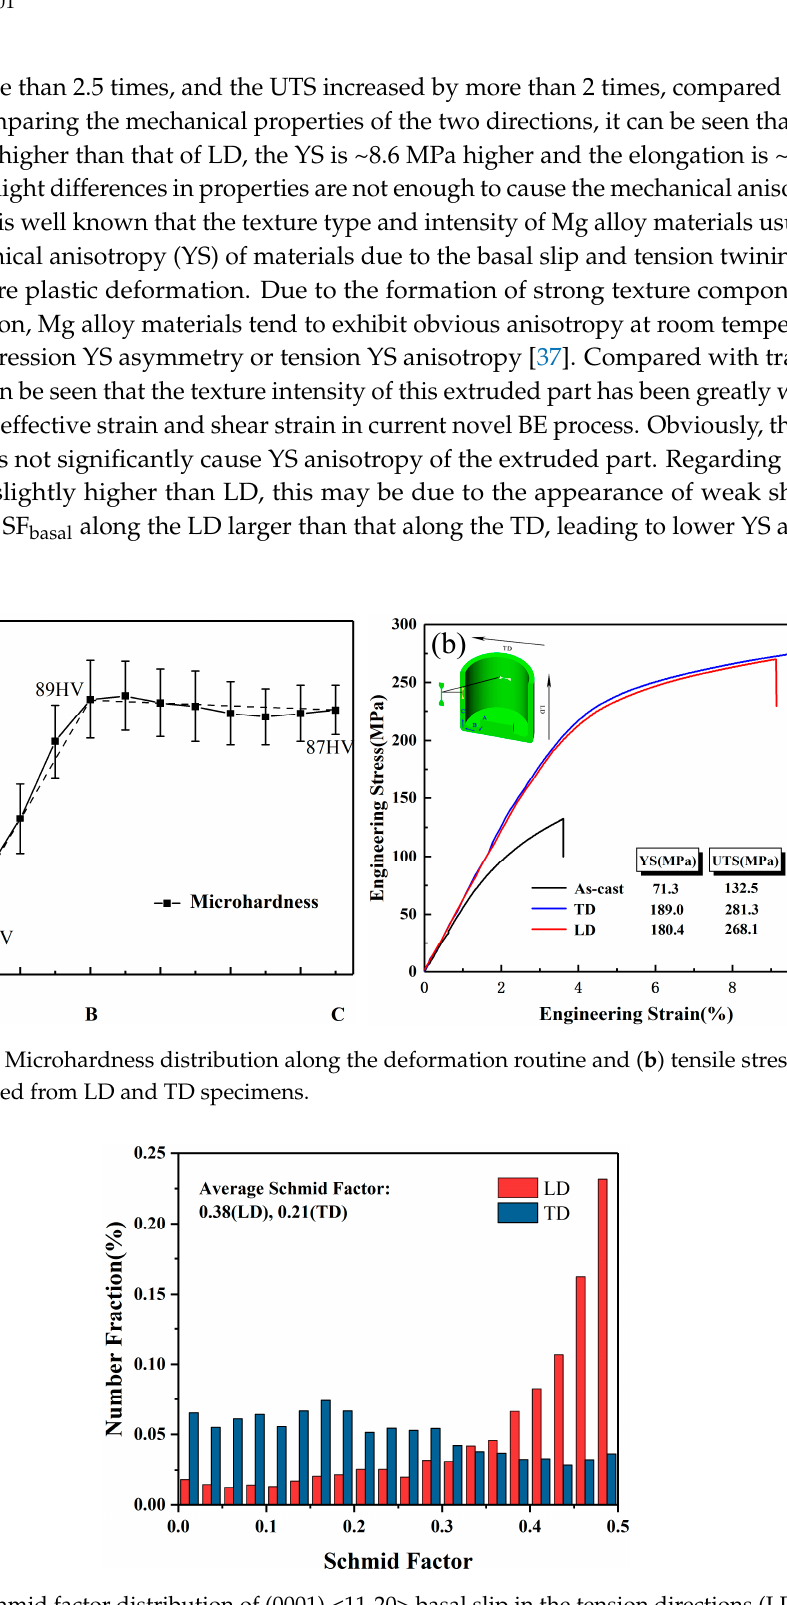
Figure 11. Schmid factor distribution of (0001) <11-20> basal slip in the tension directions (LD or TD) obtained from EBSD data.